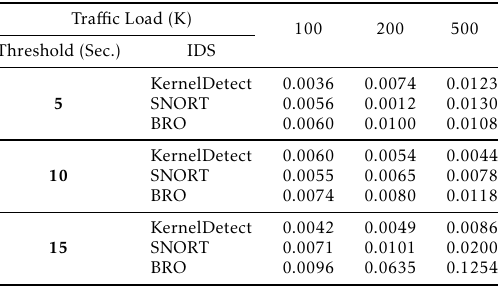
Figure 13. Memory utilization for each IDS under the scenario of a single attack with 100K SYN flagged packets (Pkt.) using a 10 second threshold detection rate. Additionally, a full-link saturation is achieved during the attack in this evaluation. Table 3. The average mitigation time in seconds for KernelDetect, SNORT and BRO under various traffic loads of 100K, 200K, and 500K SYN flagged packets using detection thresholds of 5, 10, and 15